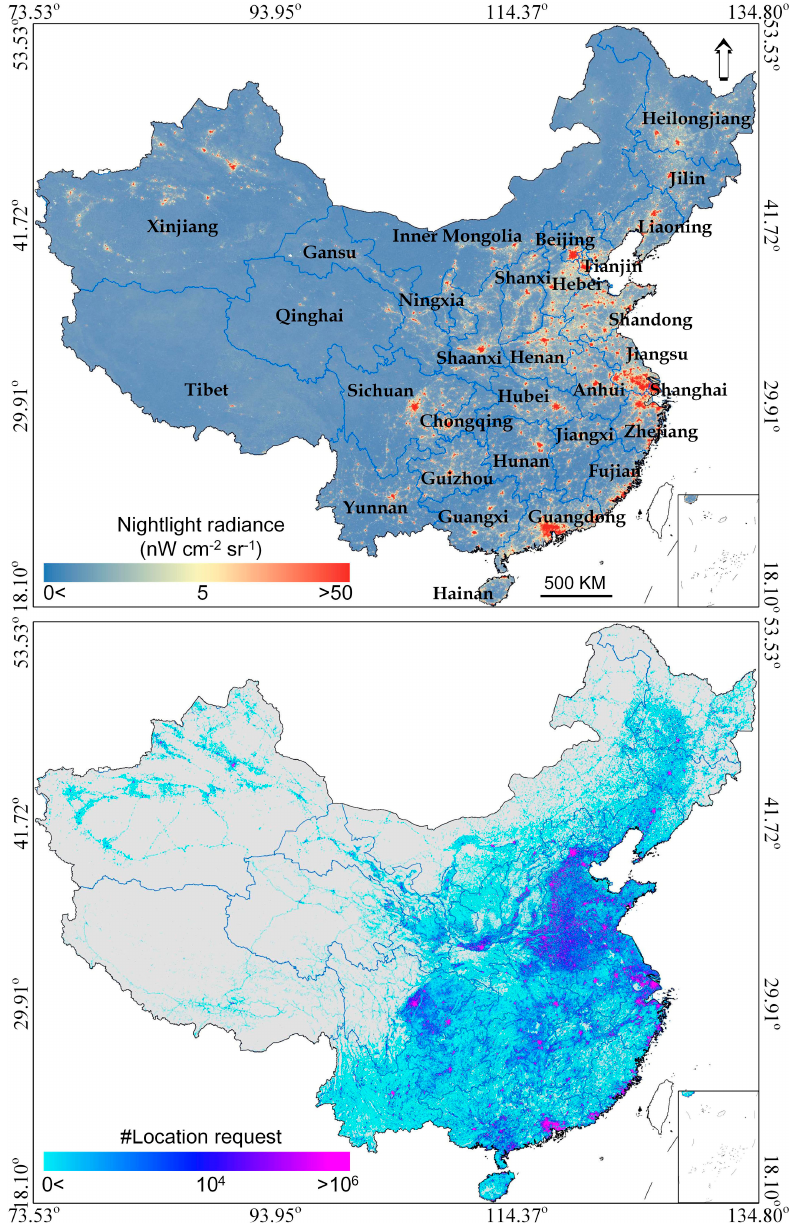
Figure 1. Spatial distributions of Visible Infrared Imaging Radiometer Suite (VIIRS) day/night band (DNB)–derived nighttime light radiances (upper, the two-month composite of February and